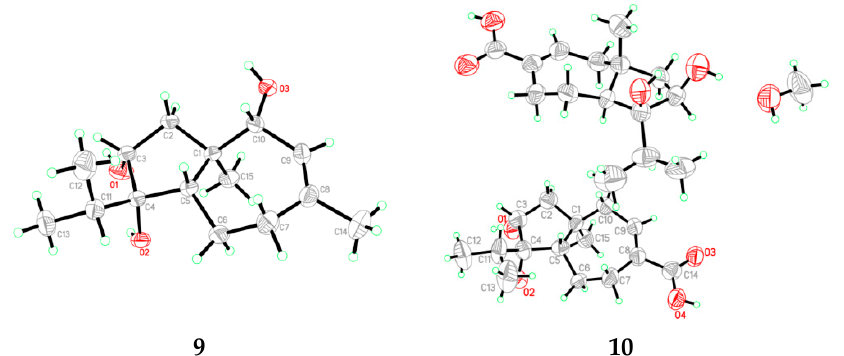
Figure 6. X-ray crystallographic structures of compounds 9 and 10 .